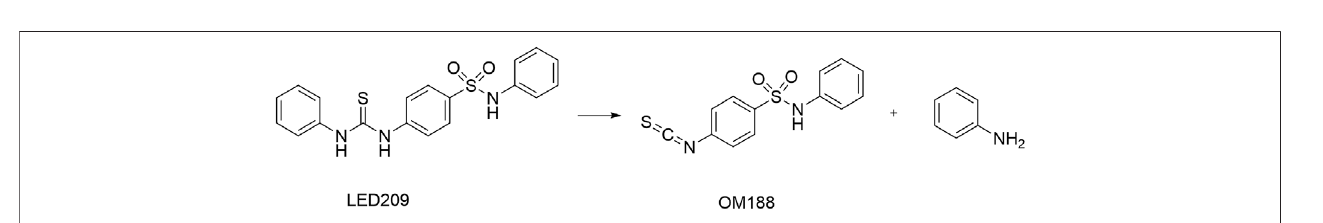
FIGURE 9 | Upon interaction with QseC, LED209 breaks into the active component of OM188 and an aniline group (Curtis et al., 2014).